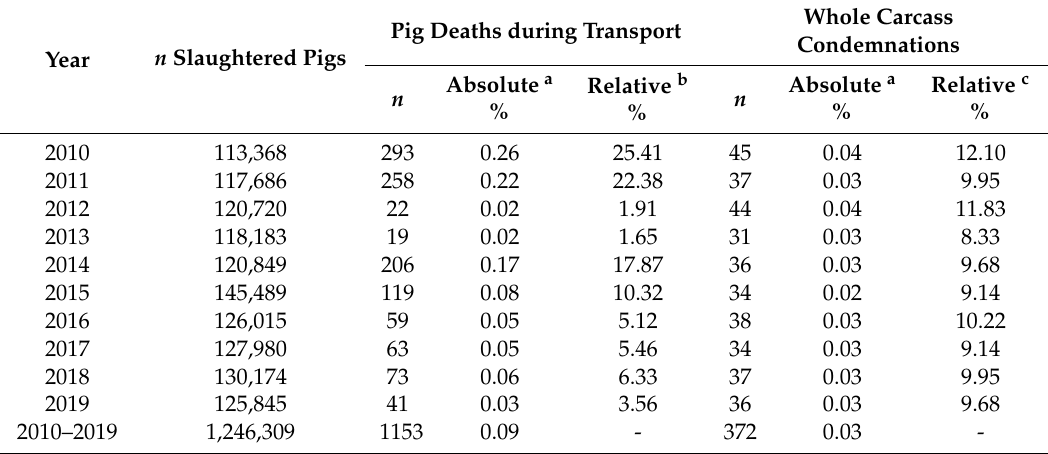
Table 1. Details of slaughtered pigs, deaths during transport, and condemned whole carcasses per year and for the total period (2010–2019) including number and absolute and relative percentage. Whole Pig Deaths during Transport n Slaughtered Pigs